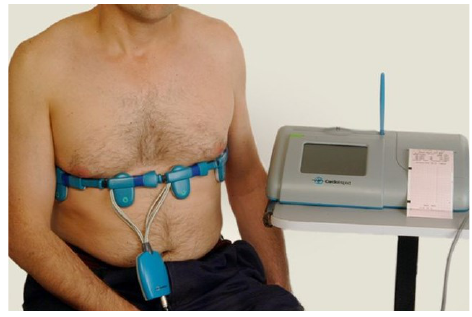
Fig. 7: Cardiac monitoring by CardioInspect system